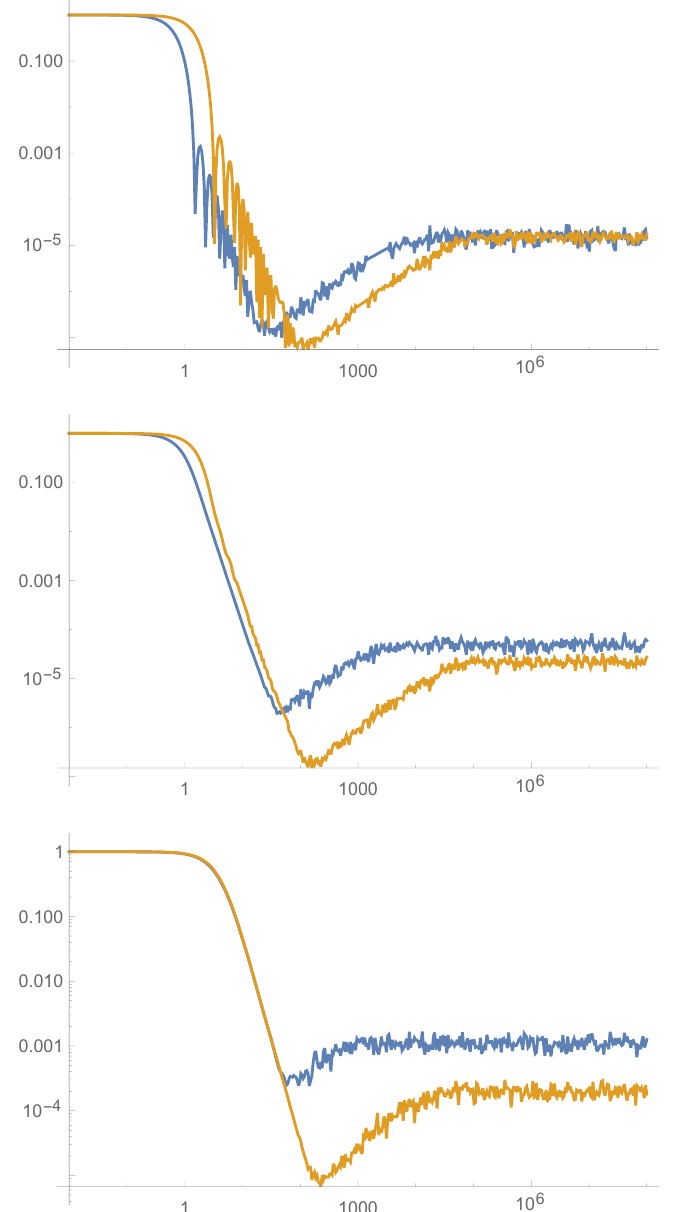
Figure 7 . The SFFs for the generalized SYK model (blue line) and for the standard SYK model (yellow line). Top: (cid:12) = 0, center: (cid:12) = 1, bottom: (cid:12) =